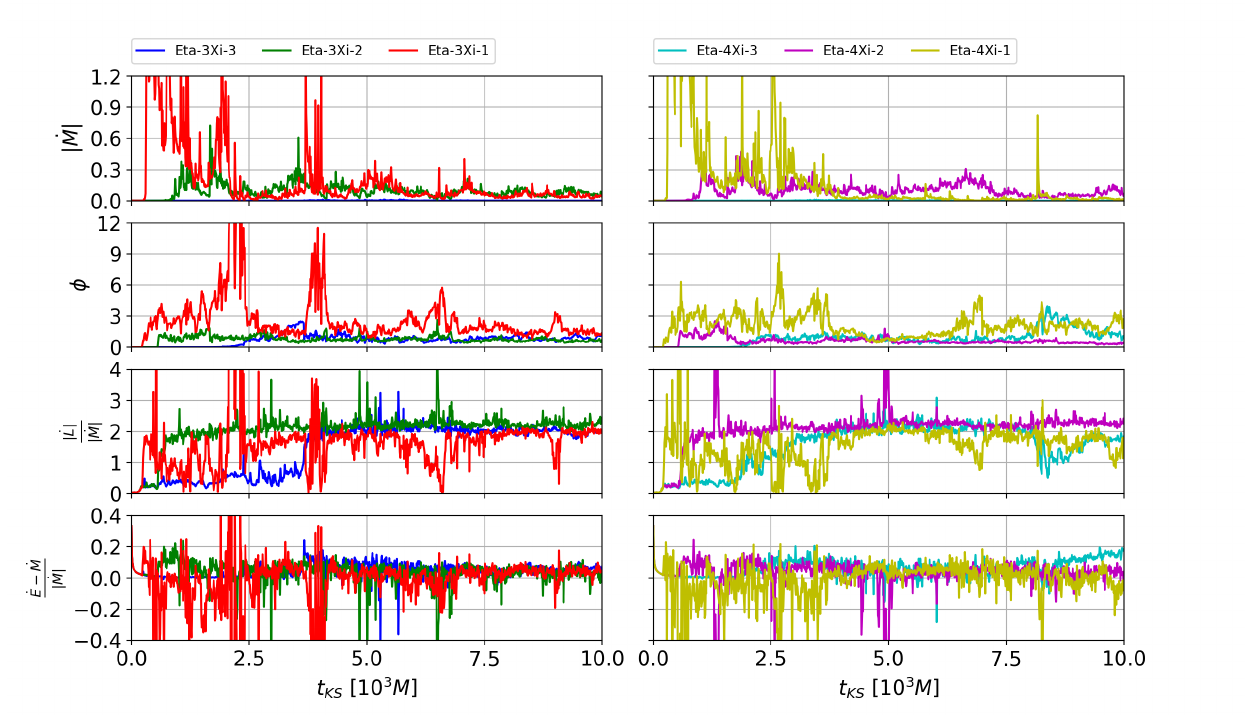
Figure 3. Time series of the horizon penetrating fluxes for each model (on the left panels, runs with η 0 = 10 − 3 ; on the right panels, runs with η 0 = 10 − 4